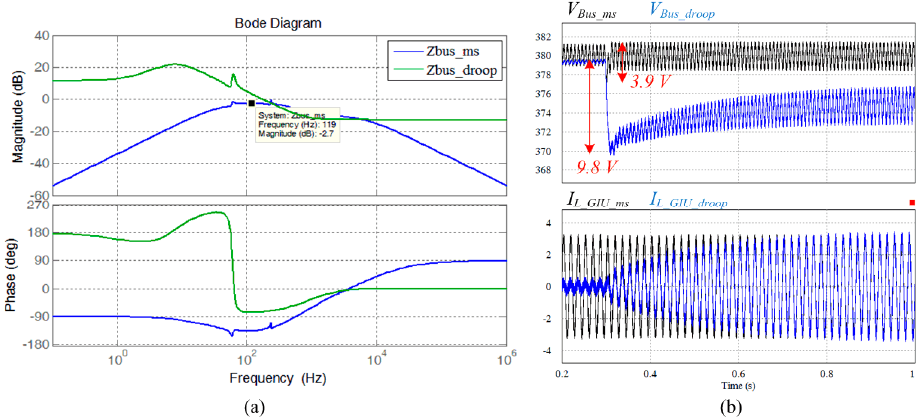
Figure 10. Comparisons between ( a ) equivalent bus impedance bode diagram and ( b ) simulation waveforms at step load changing condition.